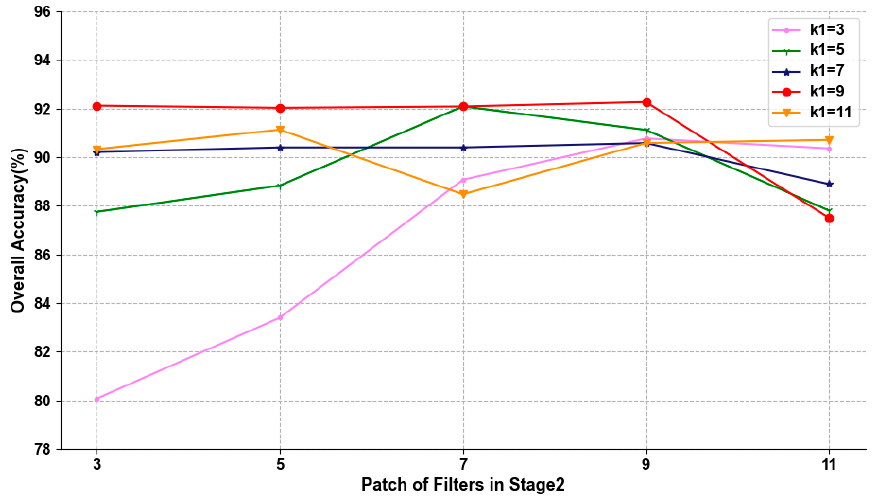
Figure 9. The influence of different filter sizes on the classification accuracy in the Bohai Bay dataset.